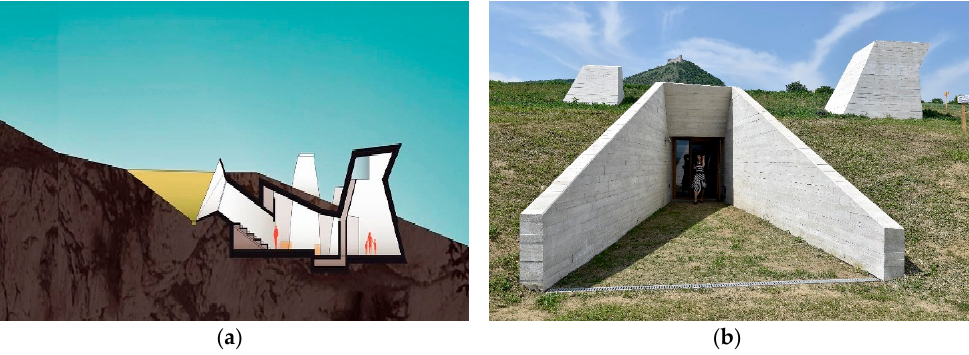
Figure 1. ( a ) Visualization of the underground construction of the archeological park in Pavlov, Czech Republic [4]; ( b ) entrance to the archeological park in Pavlov, Czech Republic (photo: Institute of Archeology of the Czech Academy of Sciences (CAS), Brno).